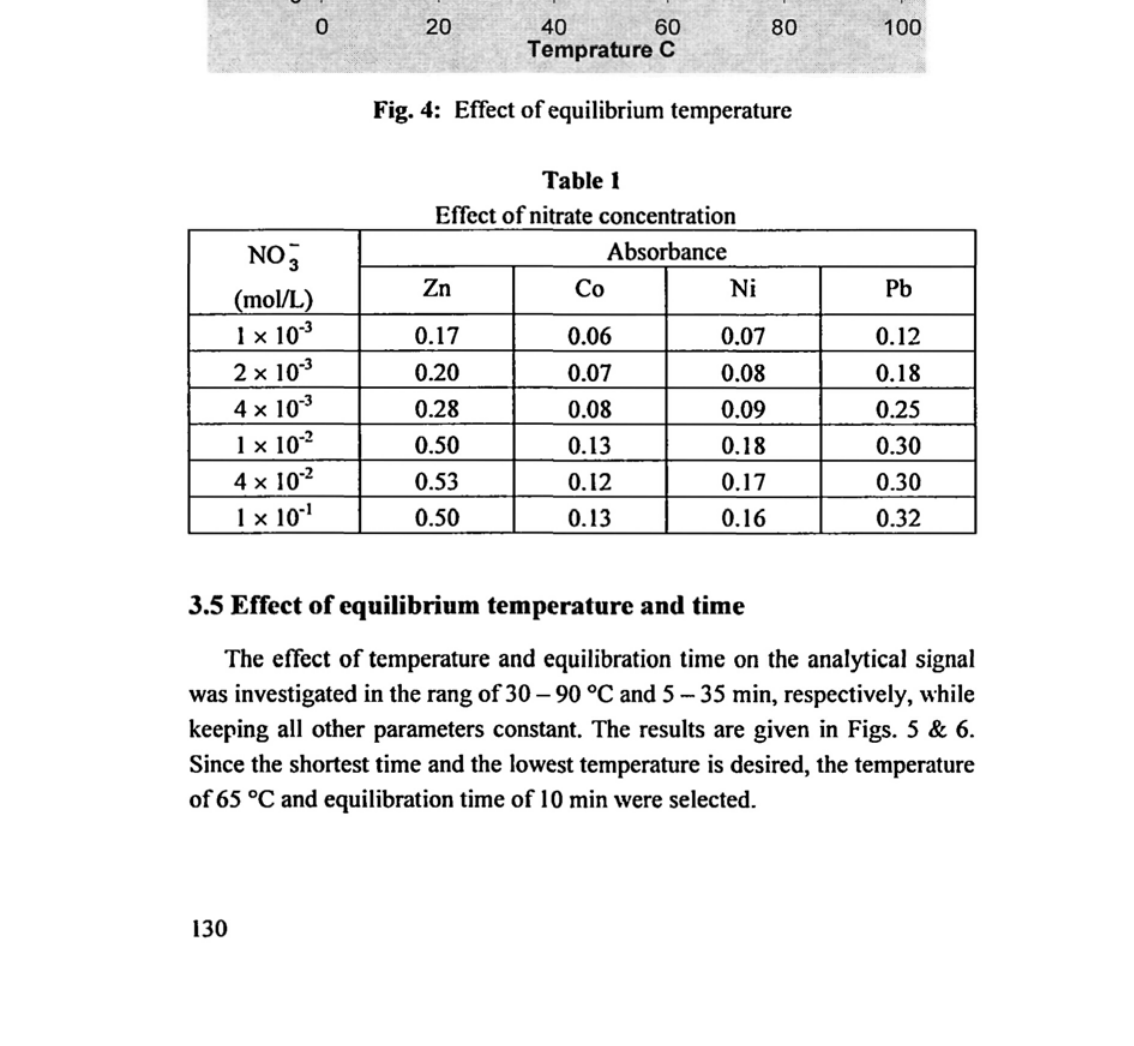
Effect of nitrate concentration